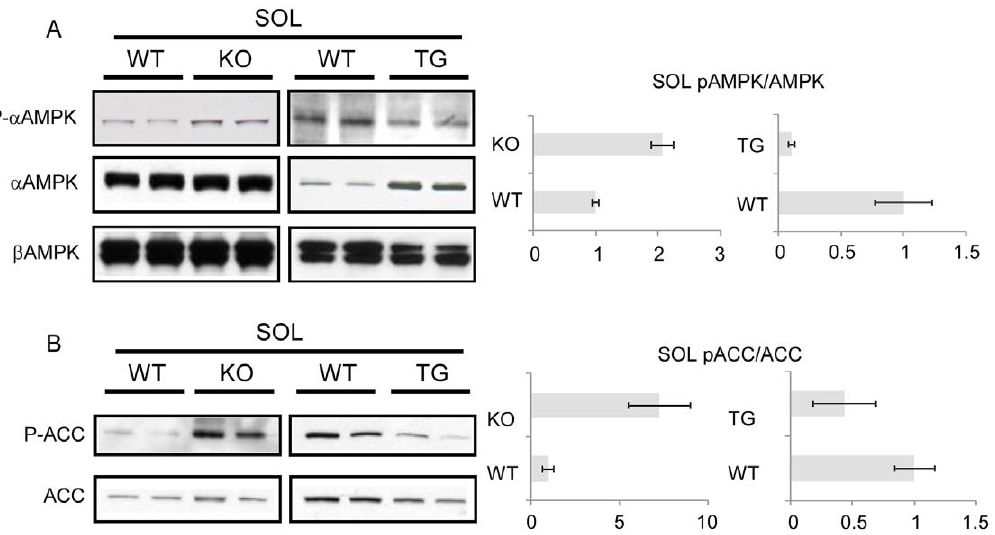
Figure 6. RIP140 modulates AMPK activity. (A) Analysis of phospho- a AMPK, total a and b AMPK expression on RIP140-null (KO), transgenic (TG) and WT soleus (SOL) by western-blot. Quantification of phospho-AMPK to AMPK ratio for western-blot expressed as mean 6 SEM. (B) Analysis of phospho-ACC and total ACC expression on RIP140-null (KO), transgenic (TG) and WT soleus (SOL) by western-blot. Quantification of phospho-ACC to ACC ratio for western-blot expressed as mean 6 SEM. Data are presented with WT set to one.